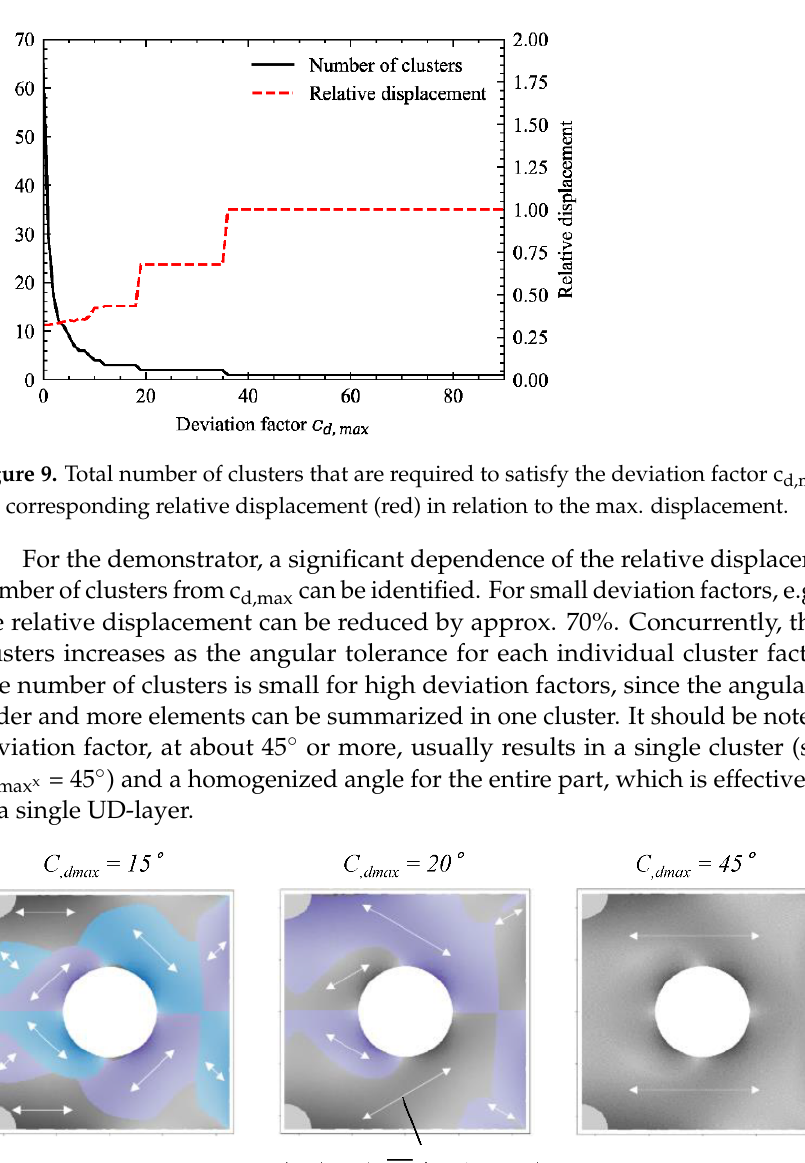
Figure 10. Resulting clusters for deviation factors of c d,max = 15°, 20°, and 45°.